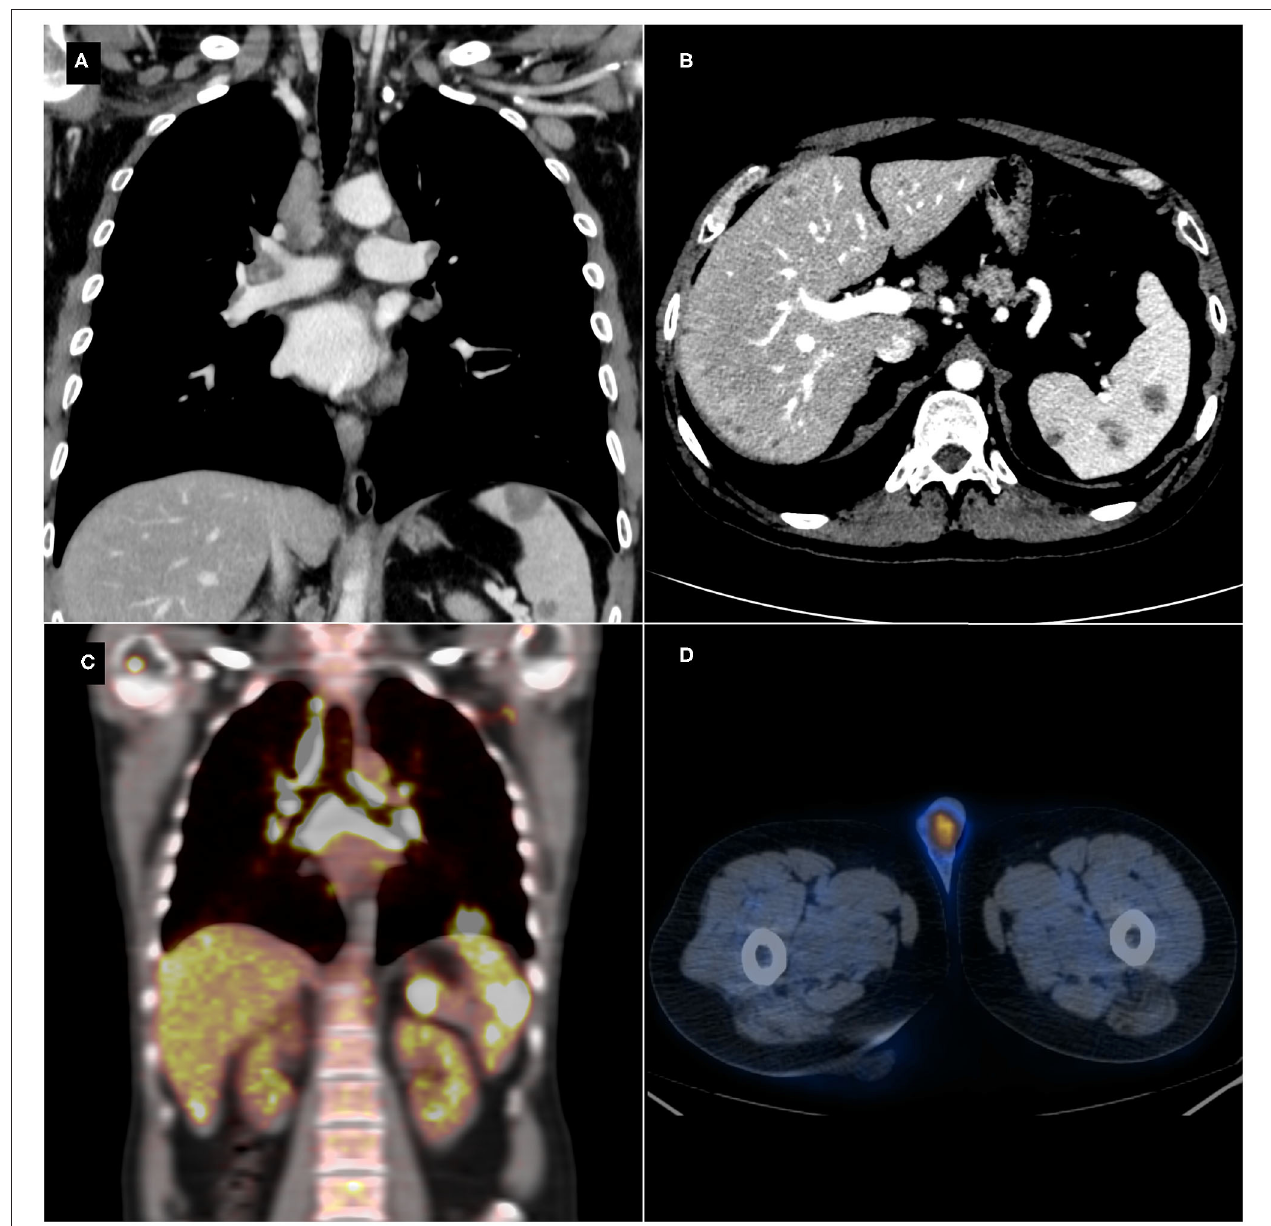
FIGURE 1 | Thoraco-abdominal contrast-enhanced computed tomography (CT) scan showing hilar and mediastinal lymphadenopathies (A) , enlarged retroperitoneal lymph nodes, and multiple hepatic and splenic hypodense lesions (B) . Positron emission tomography-computed tomography (PET/CT) detecting an increased focal 18 F-Fludeoxyglucose ( 18 F-FDG) uptake in the mediastinal and abdominal lesions (C) and in the left testis (D) .